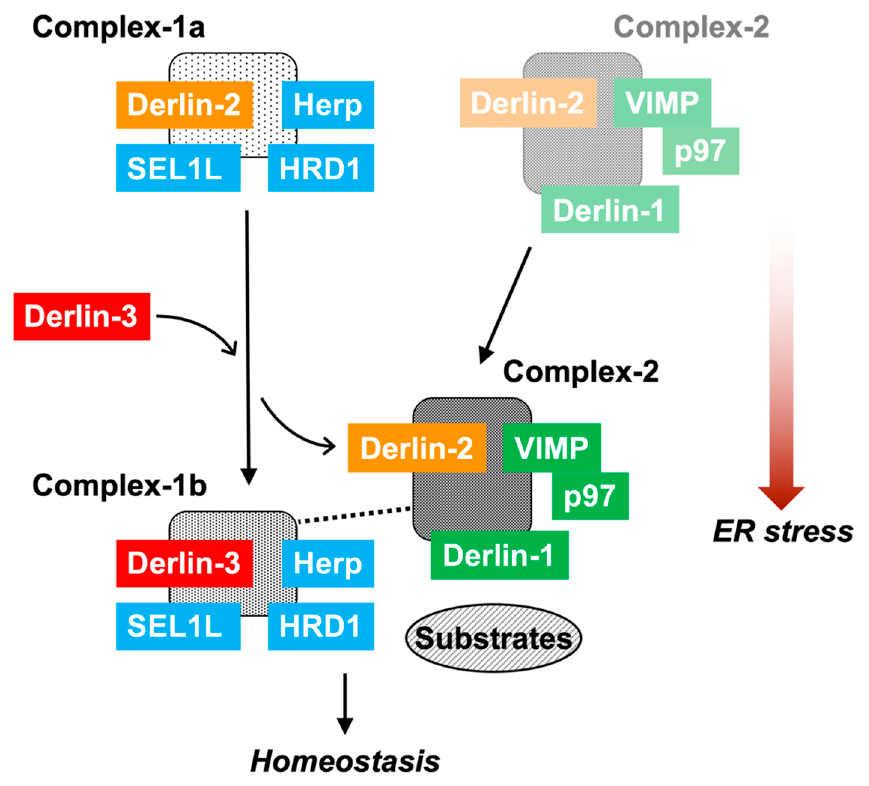
Figure 8. The role of Derlin-3 in ERAD complex formation. In the non-ER stress conditions, there are Complex-1a containing Herp, Derlin-2, HRD1, and SEL1L and a small amount of Complex-2 containing Derlin-1, Derlin-2, VIMP, and p97 on the ER membrane. In the liver, ER stress induces the expression of Derlin-3. Then, Derlin-3 is replaced by Derlin-2 to form Complex-1b containing Herp, HRD1, SEL1L, and Derlin-3. Subsequently, Derlin-2 upregulates the formation of Complex-2. Deficiency of Herp suppresses the formation of Complex-1a. Deficiency of Derlin-3 suppresses the change from Complex-1a to Complex-1b, and simultaneously, the interaction between Complex-1b and Complex-2 disappears. In the pancreas, there is chronic ER stress; therefore, Complex-1b and Complex-2 remain stationary. Deficiency of Derlin-3 results in the formation of Complex-1a and a decrease in the formation of Complex-1b and